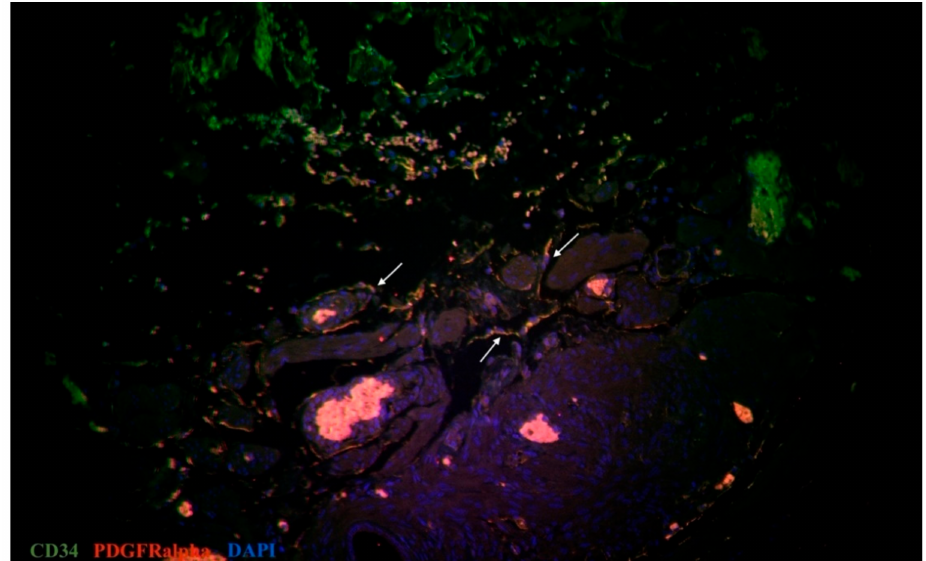
Figure 3. Double immunolabelling of human oviduct stained for PDGFR α (red, Alexa Fluor 594) and CD34 (green, Alexa Fluor 488) in the study group. Nuclei are stained by DAPI. The doubly immunopositive cell with an oval-shaped body and long cellular prolongation was identified as a telocyte (marked by an arrows). Total magnification: × 200.